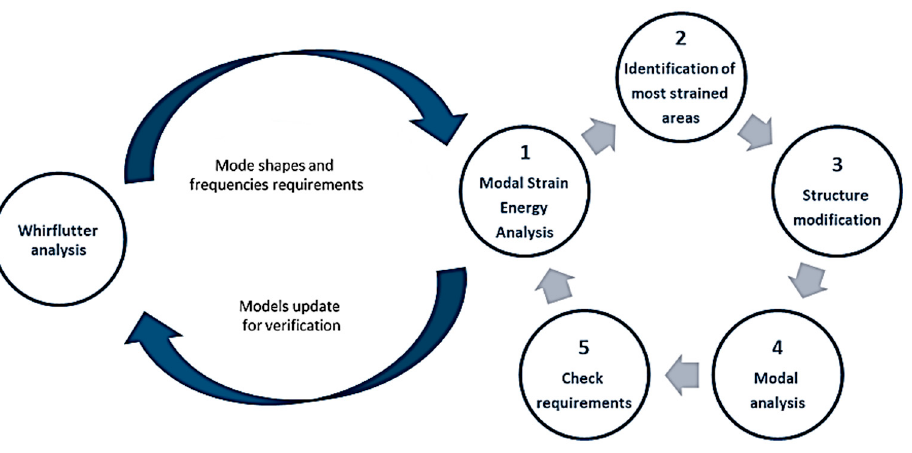
Figure 5. Aeroelastic tailoring process scheme.